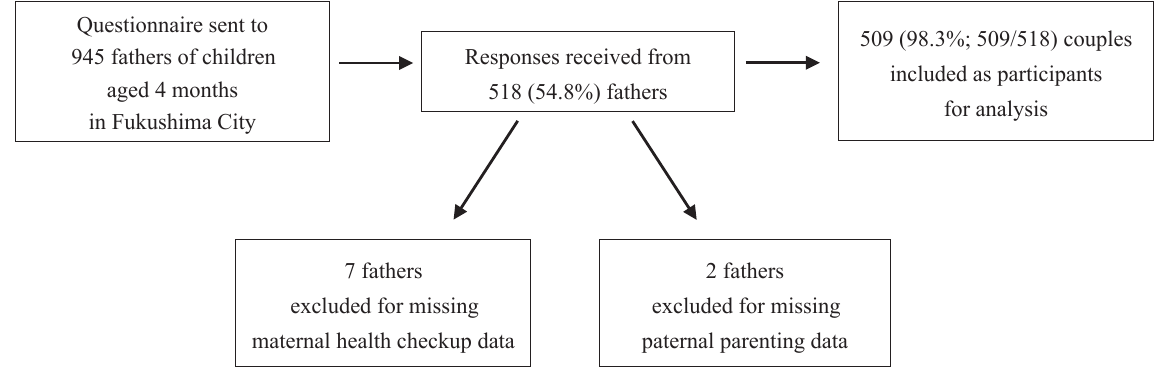
Figure 1. Recruitment and process of enrollment of study